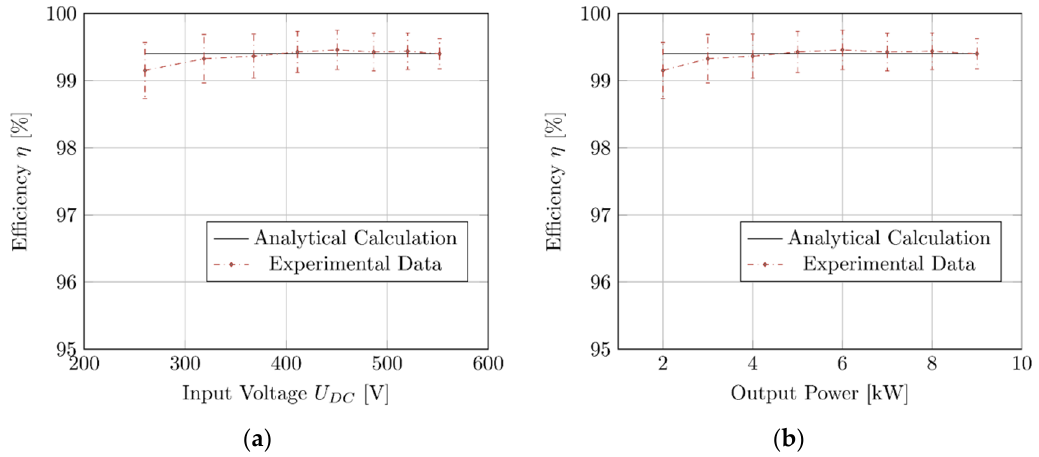
Figure 12. Efficiency vs. Input Voltage ( a ) and output power ( b ) comparison between experimental results (dashed) and analytical calculation (solid).